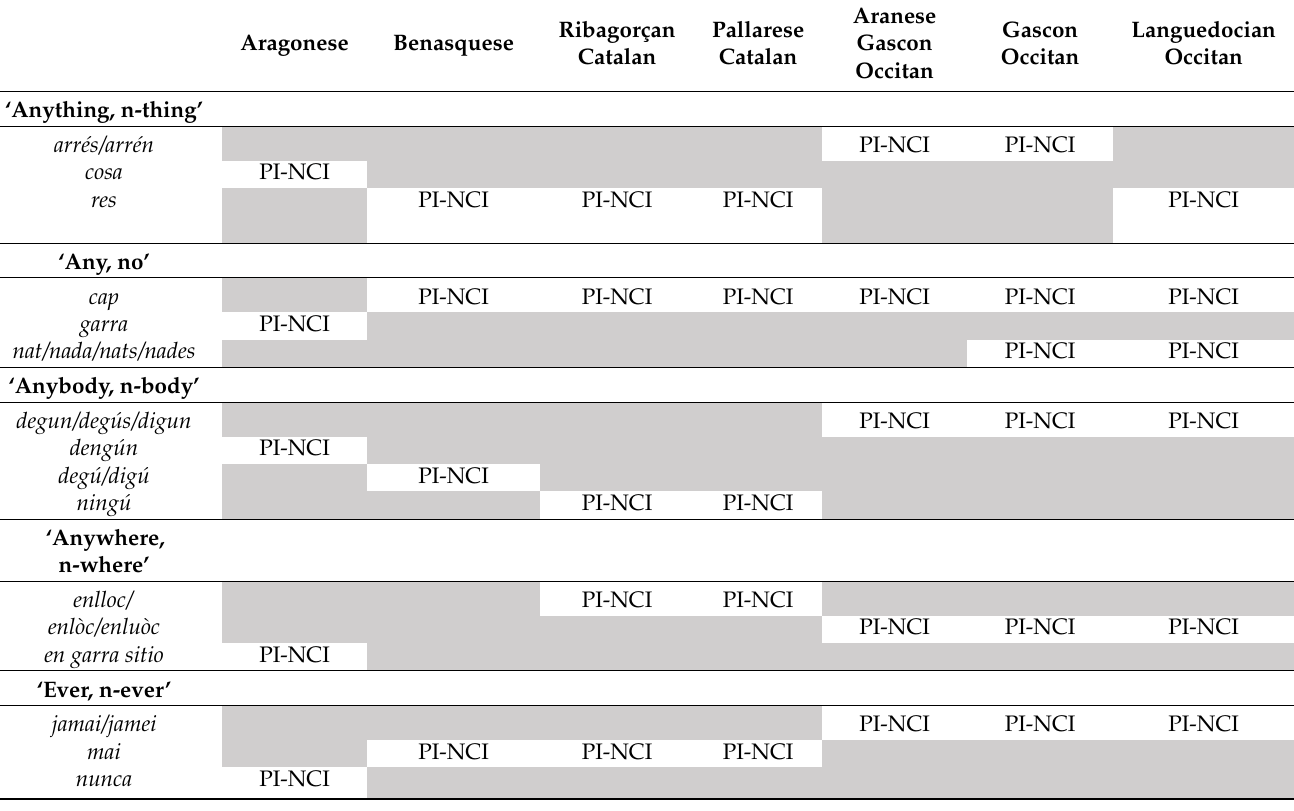
Table A2. The distribution and meaning of indefinite pronouns and specifiers in trans-Pyrenean Romance varieties.